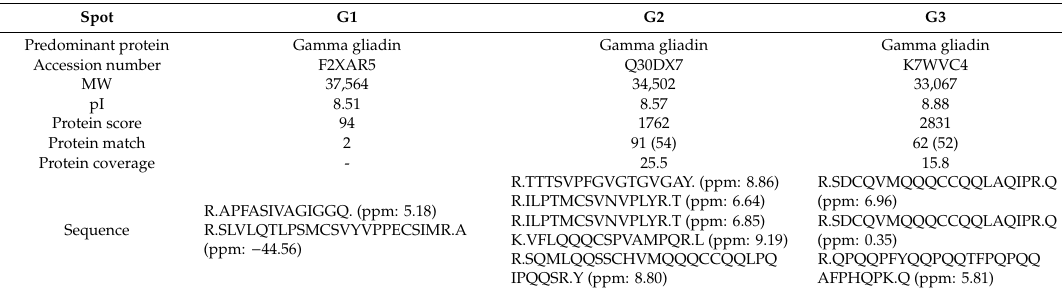
Table 1. LC-MS identification of wheat gliadin spots in 2-DE. The protein name, accession number, mass, pI, protein score, protein match, protein coverage, peptide sequence and mass error (ppm) were presented.